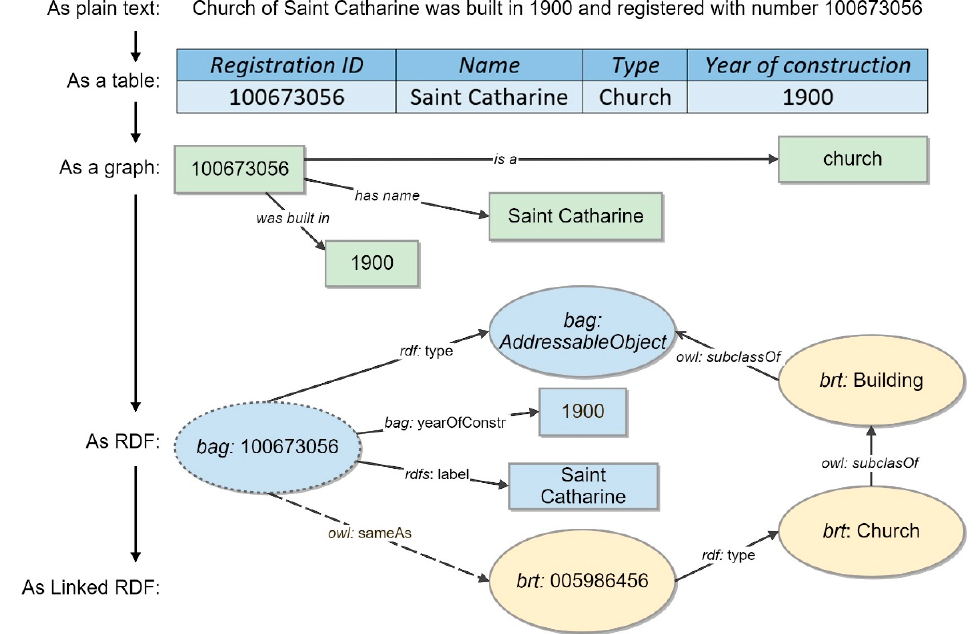
Figure 3. Representing facts from a plain text using the Resource Description Framework (RDF). Green rectangles represent a graph made by decomposing a plain text into facts with arbitrary wording. Blue shapes represent the same graph but expressed with standardized vocabularies and URIs. Yellow shapes represent data items from another dataset (BRT), which are linked to the blue ones (BAG), forming a part of a knowledge graph (KG; source: authors).